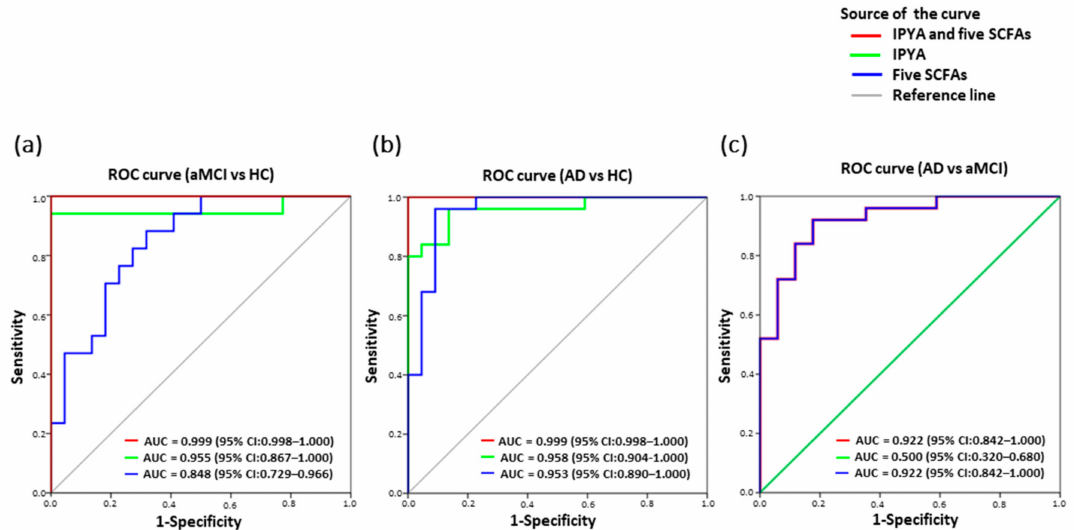
Figure 6. Classification and prediction of AD patients using the panel of six fecal microbial metabolites. Predictive models based on IPYA of tryptophan metabolites and five SCFAs (formic acid, acetic acid, propanoic acid, 2-methylbutyric acid and isovaleric acid) were built by performing binary multivariable logistic regression analysis. ROC curves were calculated for discriminating ( a ) aMCI from HC, ( b ) AD from HC, and ( c ) AD from aMCI. Abbreviations: ROC, receiver operating characteristic; AUC, area under the ROC curve; CI, confidence